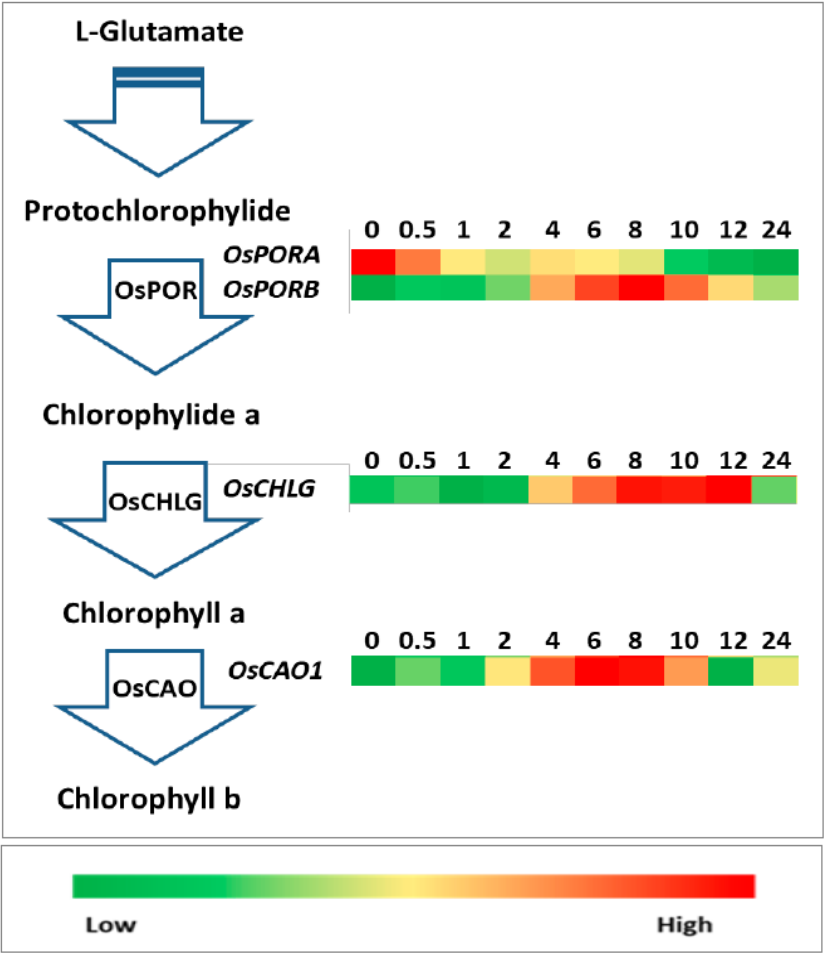
Figure 6. Relative expression levels of chlorophyll biosynthesis pathway genes in etiolated rice leaves during de-etiolation at different times after the onset of irradiation with white light.